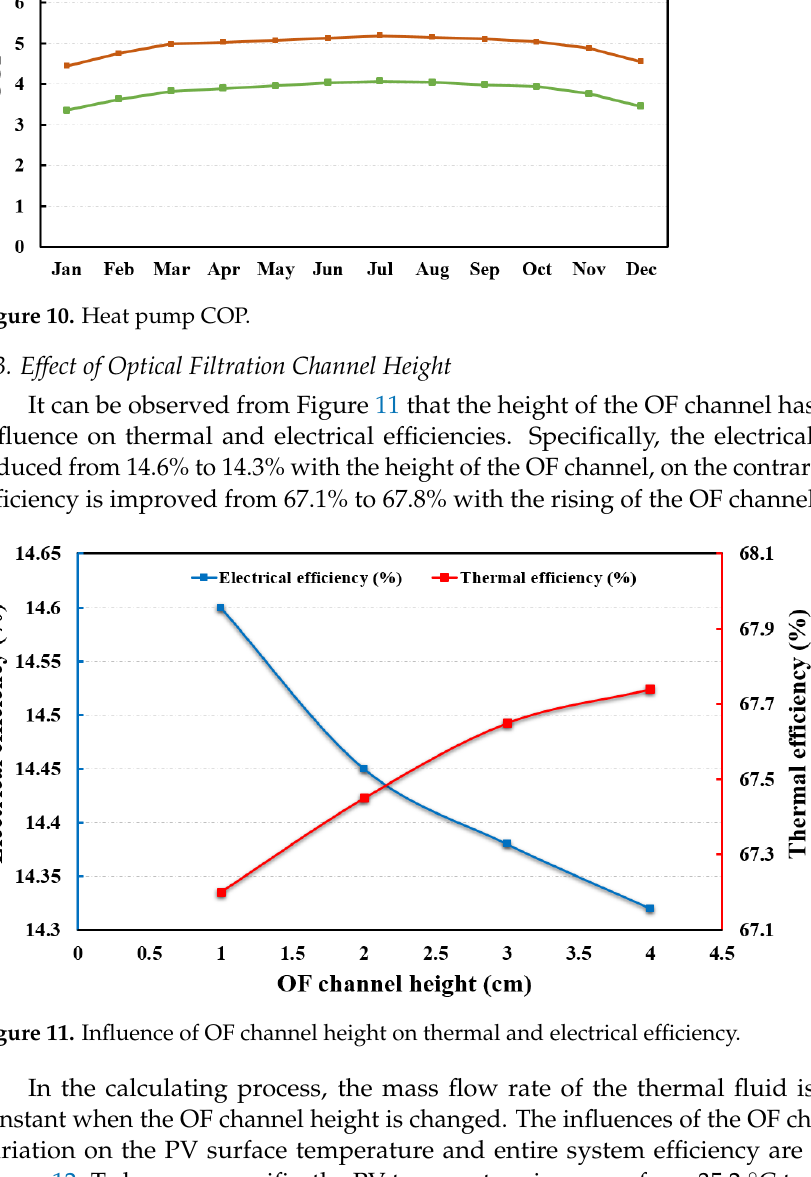
Figure 9. Electrical consumption of heat pump.